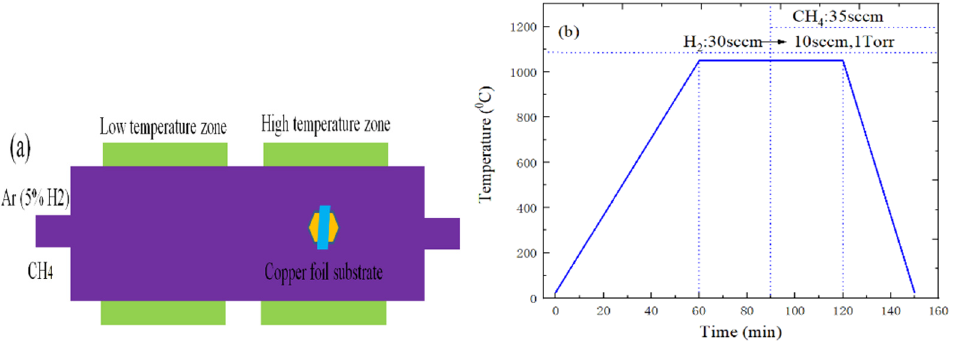
Figure 12. ( a ) the preparation schematic diagram of graphene; ( b ) temperature change curve of graphene.